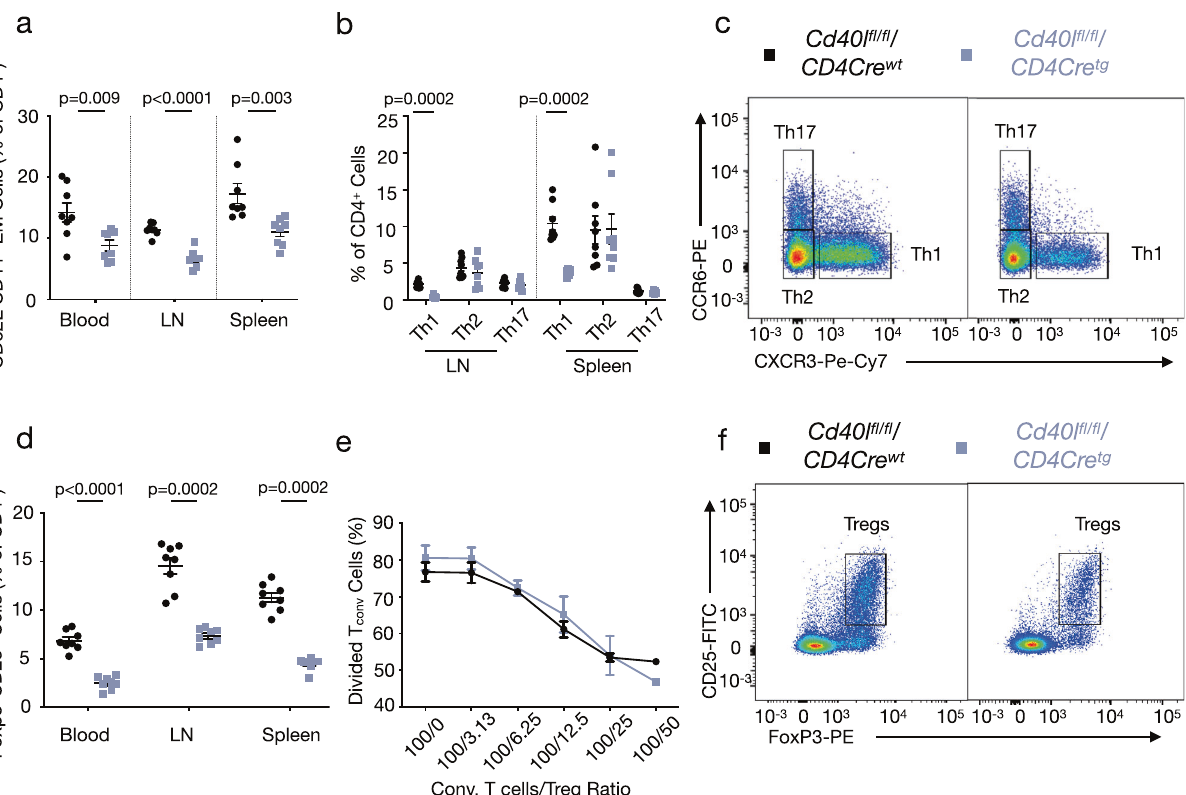
Fig. 3 T cell CD40L de fi ciency leads to profound reductions in Th1 and Treg responses. a Flow cytometric analysis of effector memory (EM) T cells in the blood [ n = 8], LNs [ n = 8], and spleen [ n = 8]. b Flow cytometric analysis of effector T cell subpopulations including T helper (Th) 1 (CD62L − CD44 + CXCR3